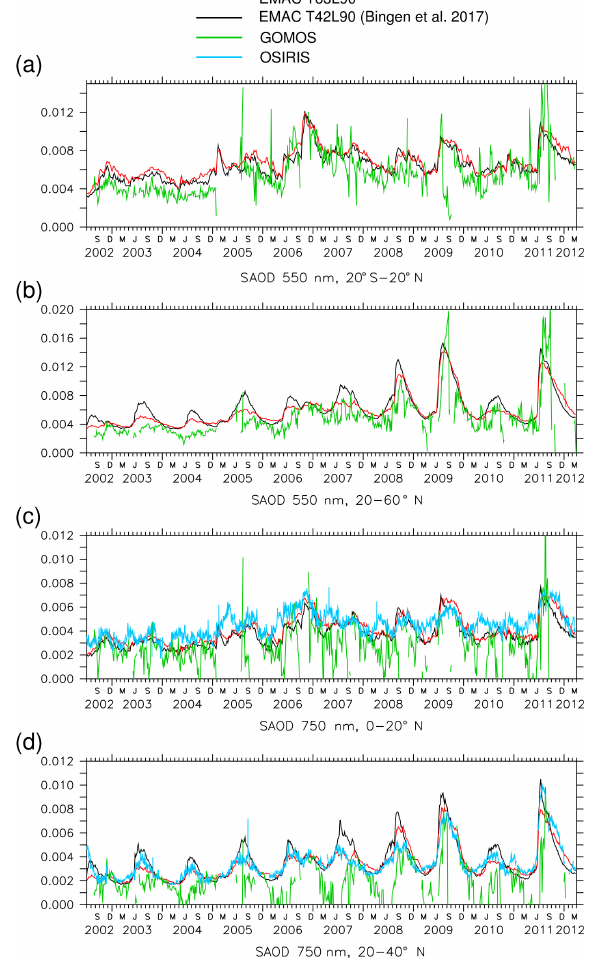
Figure 4. (a, b) Stratospheric AOD at 550nm observed by GOMOS (green) and simulated by EMAC in resolutions T42L90 (black) and T63L90 (red). (c, d) Stratospheric AOD at 750nm in the north- ern tropics and subtropics (SAOD above 15km), additionally with OSIRIS observations (light blue).